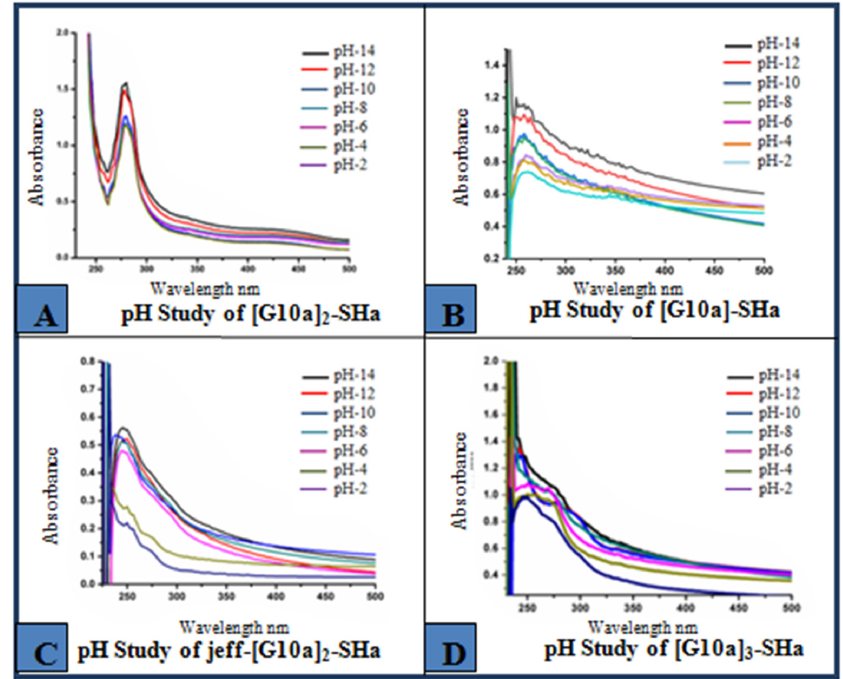
Figure 7. pH studies of monomer and dendrimer peptides ( A ) [G10a] 2 -SHa ( B ) [G10a]-SHa ( C ) Jeff-[G10a] 2 -SHa ( D ) [G10a] 3 -SHa at different ranges of pH from pH 2 to pH 14. Temporin SHa has been shown to possess antibacterial activity. Similarly, its deriva- tive [G10a]-SHa was tested and found to be active against H. pylori [16] and methicillin- resistant Staphylococcus aureus (MRSA) [15]. The antibacterial activity of [G10a]-SHa and its dendrimers was further tested and compared to SHa using various Gram-negative as well as Gram-positive bacterial strains, as shown in Table 4. Temporin SHa was found to be active on all the bacterial strains tested (MIC ranging from 1.56 to 50 µM). Its derivative [G10a]-SHa was found to be active on A. baumannii , E. coli , H. pylori , K. pneumoniae , B. subtilis , E. faecalis , S. aureus (with MIC ranging from 3.12 to 100 µM). However, on the other hand, contrarily to temporin, SHa[G10a]-SHa was not effective against E. cloacae , P. aeruginosa , and E. faecium (MIC > 100 µM). When comparing the activity of the dendrimers with [G10a]-SHa, it appeared that, depending on the strain tested, the dendrimers can have lower, similar or higher activity compared to [G10a]-SHa. For example, on A. bau- mannii , dendrimer [G10a] 3 -SHa was found to be four times more active than [G10a]-SHa, [G10a] 2 -SHa or Jeff-[G10a] 2 -SHa (MIC of 3.12 µM versus 12.5 µM). Similarly, on E. coli , [G10a] 3 -SHa was found to be four times more active than [G10a]-SHa (MIC of 25 µM ver- sus 100 µM), whereas [G10a] 2 -SHa and Jeff-[G10a] 2 -SHa were found to be inactive (MIC > 100 µM). On H. pylori , [G10a] 2 -SHa, [G10a] 3 -SHa and Jeff-[G10a] 2 -SHa were all found to be less active than [G10a]-SHa ((MIC of 6.25, 25 and 25 µM versus 3.12 µM). On K. pneu- moniae , although [G10a]-SHa gave a weak activity (MIC of 100 µM), none of the den- drimers were found to be active (MIC > 100 µM). Regarding Gram-positive bacteria, alt- hough the dendrimers gave the same MIC value as [G10a]-SHa on B. subtilis (i.e., MIC of 3.12 µM), differences were found using other strains. On E. faecalis , dendrimer [G10a] 2 - SHa was found to be twice as active than [G10a]-SHa or the other dendrimers (MIC of 12.5 µM versus 25 µM). On E. faecium , [G10a]-SHa was found to be inactive, but the dendrimers were active with MIC ranging from 6.25 to 12.5 µM. Finally, on S. aureus , [G10a] 2 -SHa was